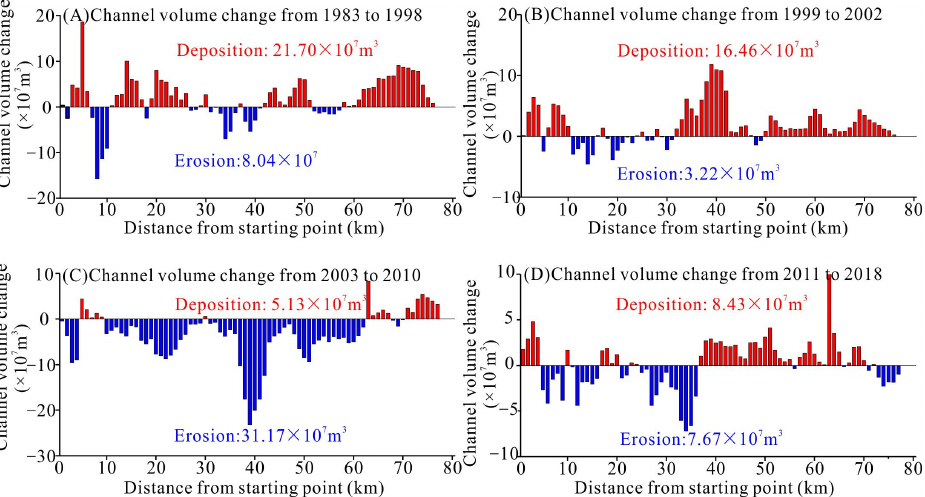
Figure 5. The SCSP channel dynamics over time. ( A ) Chanel volume change in the SCSP from 1983 to 1998. ( B ) Chanel volume change in the SCSP from 1998 to 2002. ( C ) Chanel volume change in the SCSP from 2002 to 2010. ( D ) Chanel volume change in the SCSP from 2010 to 2018.